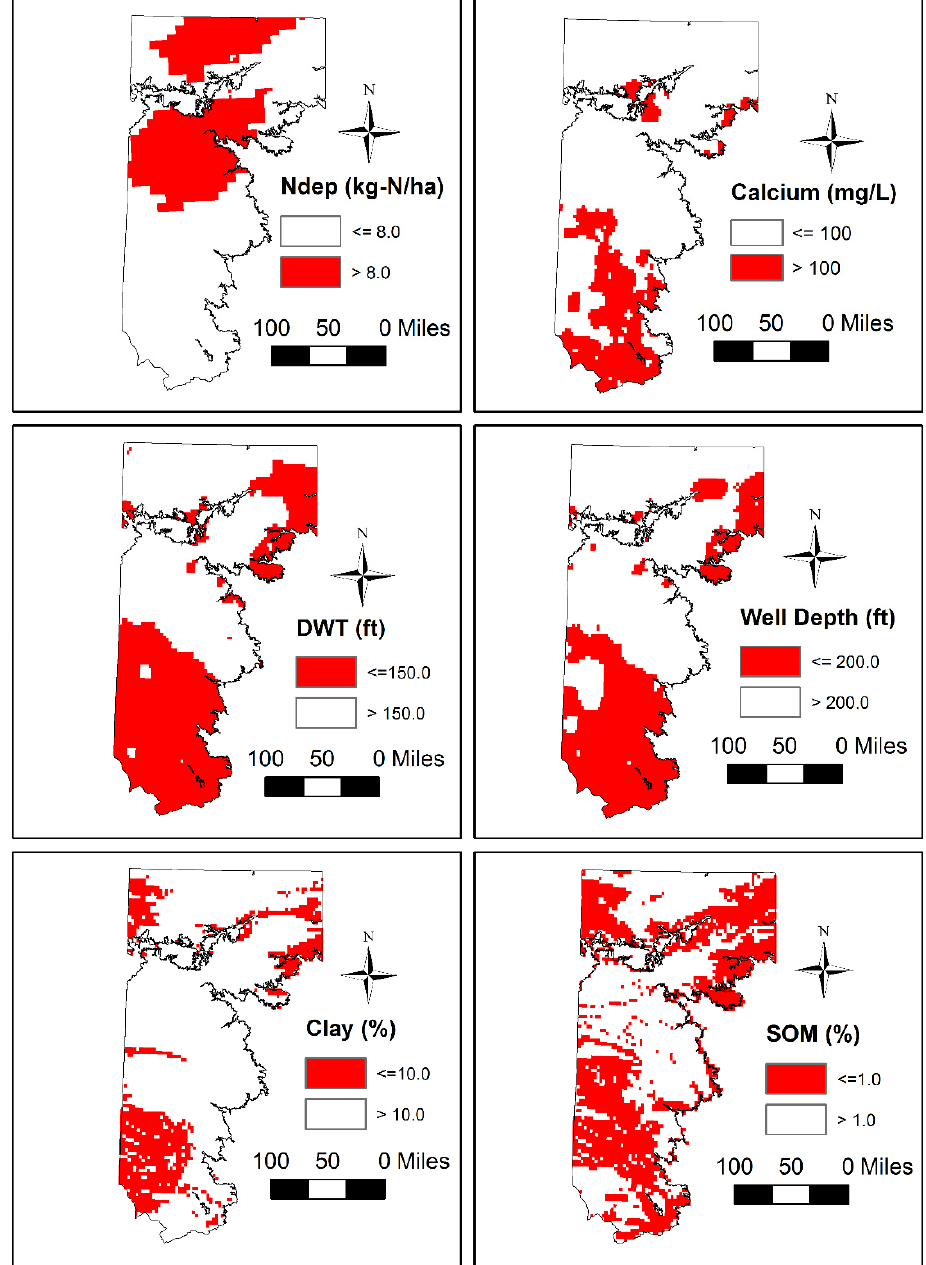
Figure 6. Spatial Distribution of Salient Model Parameters Identified using Tree-Based Techniques.